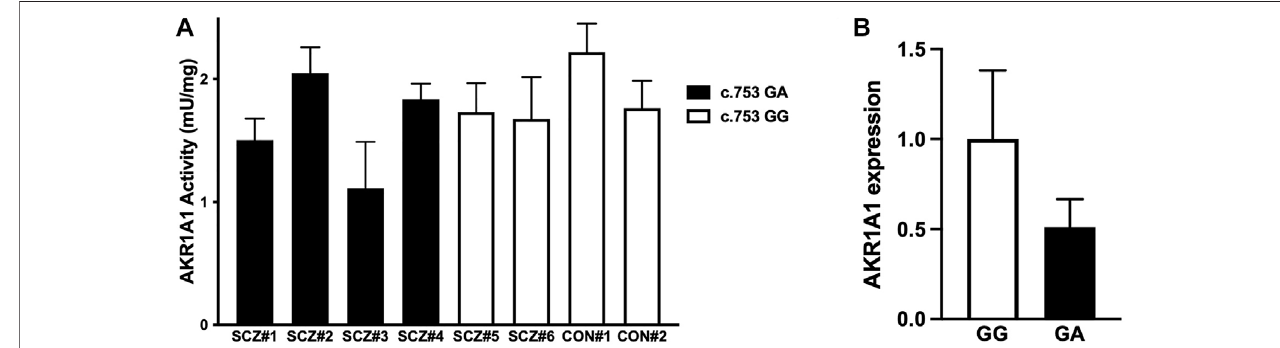
FIGURE 3 | AKR enzymatic activity and AKR1A1 gene expression in human. (A) The enzymatic activities of AKR in the red blood cells of six patients with schizophrenia (SCZ#1 to #4 with the c.753G > A variant and SCZ#5 and #6 without the variant) and two control subjects (CON#1 and #2 without the variant) were examined. Data represent mean ± SD of three independent experiments. (B) The AKR1A1 mRNA expression in fi ve subjects (SCZ#1, SCZ#3, SCZ#4, SCZ#6, and CON#2) was quanti fi ed by qPCR. For relative expression, each expression was normalized to average of SCZ#6 and CON#2 with GG alleles using the ΔΔ C T calculation. Data represent mean ±